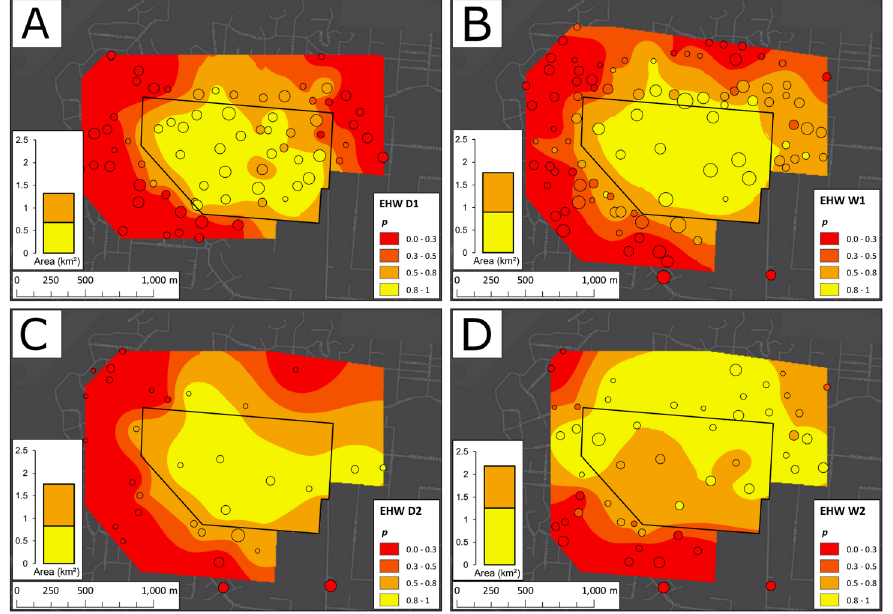
Fig 3. Ordinary Kriging of infection frequency ( p ) among traps at Edge Hill/Whitfield (EHW). Kriging (spatialaveraging)was performed using an exponentialsemivariogram model and a 24-point, nearest- neighboursearch function for the first dry season (D1) (panelA), the first wet season (W1) (B), the second dry season (D2) (C), and the second wet season (W2) (D). The central black polygondepicts the release zone. Trap locationsare plotted as circles atop each Krigingmap and are sized by a logarithmicfunction of the trap yield from each season. To the left of each Kriging plot, a stacked column chart displaysthe areas enclosed by the p > 0.8 and p > 0.5 contours. Although a contractiontook place in D2, the area increasedin W2, despite infectionfrequencydecreasingin severalsites within the release